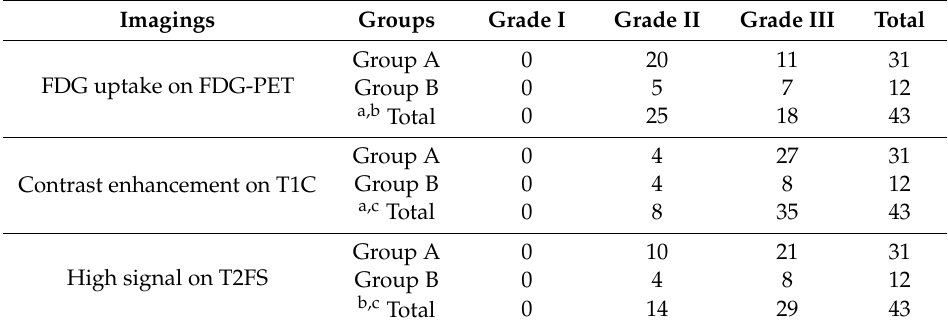
Table 4. The distribution patterns of FDG uptake on FDG-PET, contrast enhancement on T1-weighted contrast magnetic resonance imaging, and high signal intensity on T2-weighted fat saturation magnetic resonance